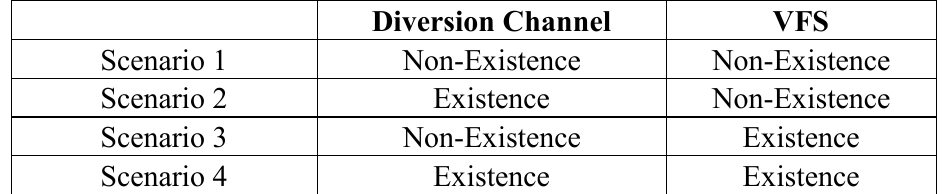
Table 1. Summary of Scenarios.